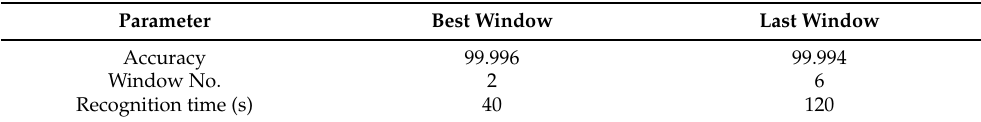
Table 3. Summary of performance of SVM-C